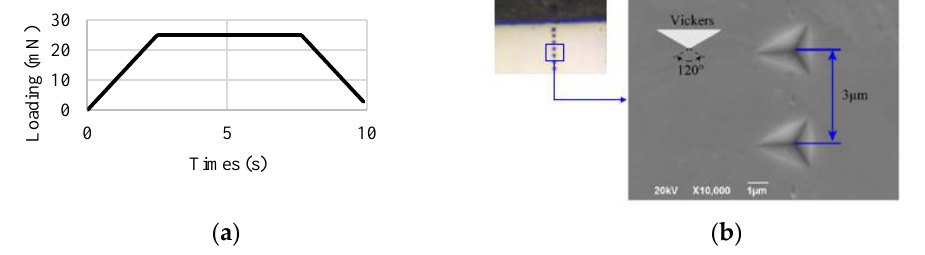
Figure 12. Loading–time curves for the indents carried out in the surface areas of machined workpiece ( a ) and examples of SEM images of indents ( b ).